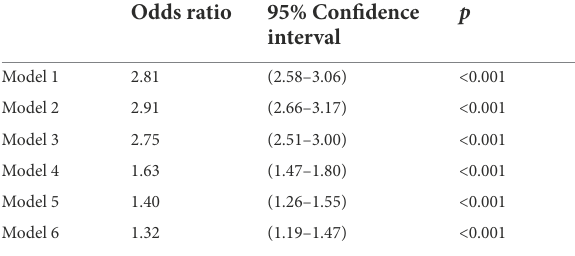
TABLE 3 Association between early positive yeast cultures and hospital mortality using an extended model approach.